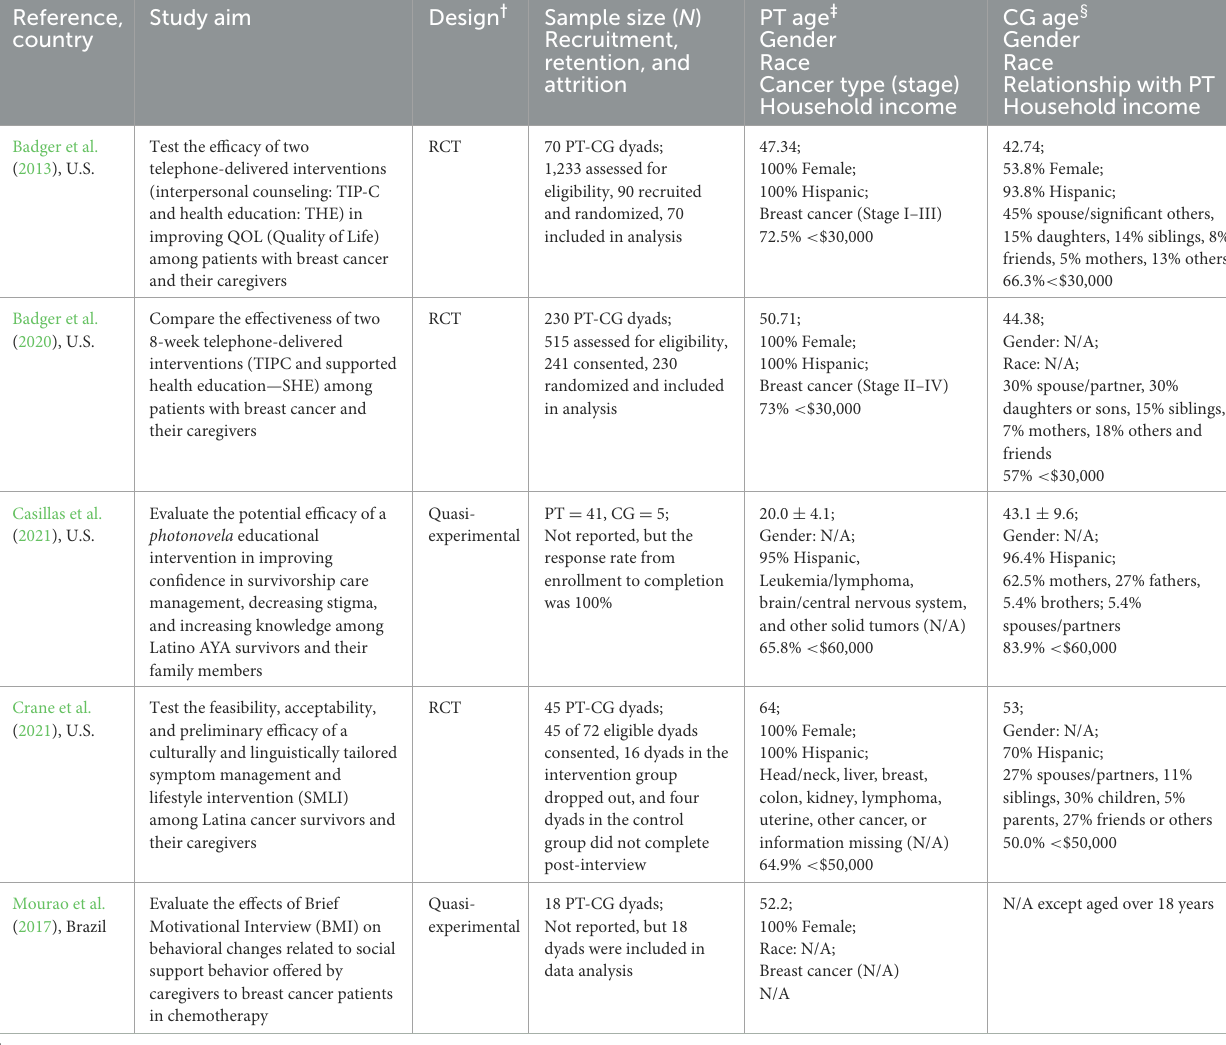
TABLE 1 Study and participant